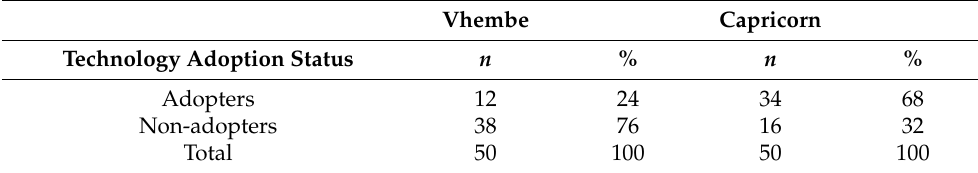
Table 6. Adoption status of CSIT in the study area. Vhembe Capricorn Technology Adoption Status n % n % Adopters 12 24 34 68 Non-adopters 38 Total 50 100 50